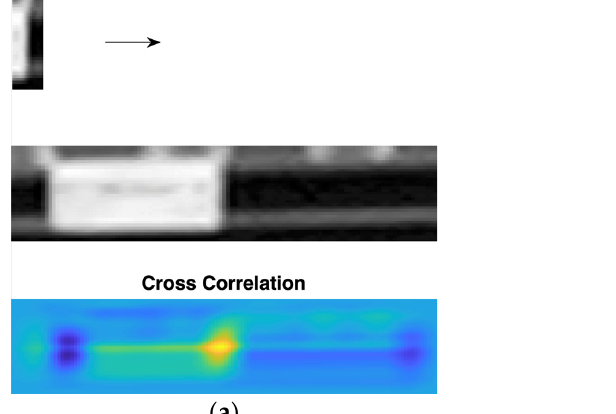
Figure 5. Motion extraction from DIC: ( a ) procedure of cross correlation; ( b ) extracted displacement.